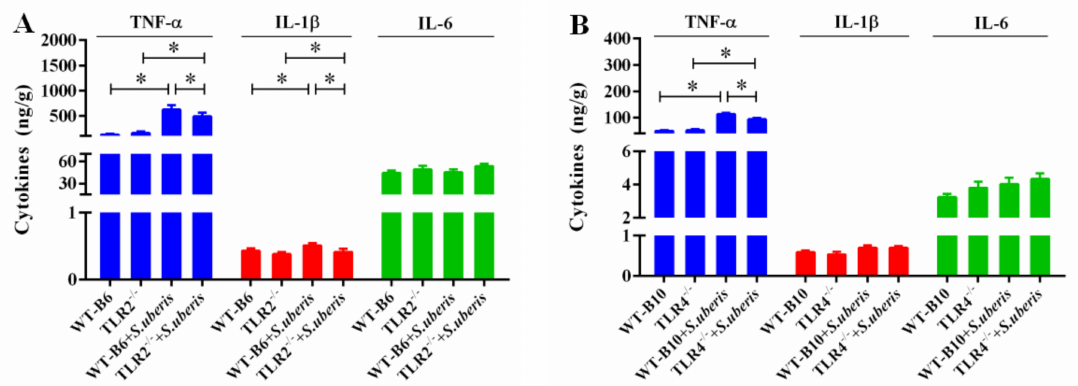
Figure 2. TLR2 and TLR4 deficiencies a ff ect the secretion of cytokines in S.uberis infection. ( A , B ) The protein expressions of TNF- α , IL-1 β and IL-6 were determined by ELISA in mammary gland of WTB6, WTB10, TLR2 − / − and TLR4 − / − mice with or without S. uberis . A is for the protein expressions for TLR2 − / − group and B is for the TLR4 − / − group. Experiments were repeated three times and all data were presented as the means ± SEM ( n = 6). * ( p < 0.05) = significantly di ff erent between the indicated